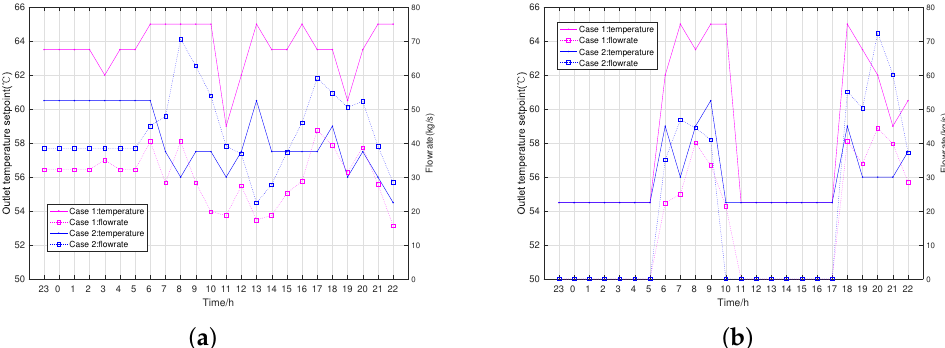
Figure 13. The operation result of HP from the perspective of flowrate and temperature analysis. ( a ) the temperature and flowrate results of HP1; ( b ) the temperature and flowrate results of HP2. It should be noted that the trends of the outlet temperature of the heat exchanger attached to WHB and HP are opposite because their mixed temperature has to be within ] . As shown in Figure 14a, the outlet the range of upper and lower limits [ T min , T max H H temperature of WHB in Case 2 stabilizes at 70.5 ◦ C and is higher than that in Case 1